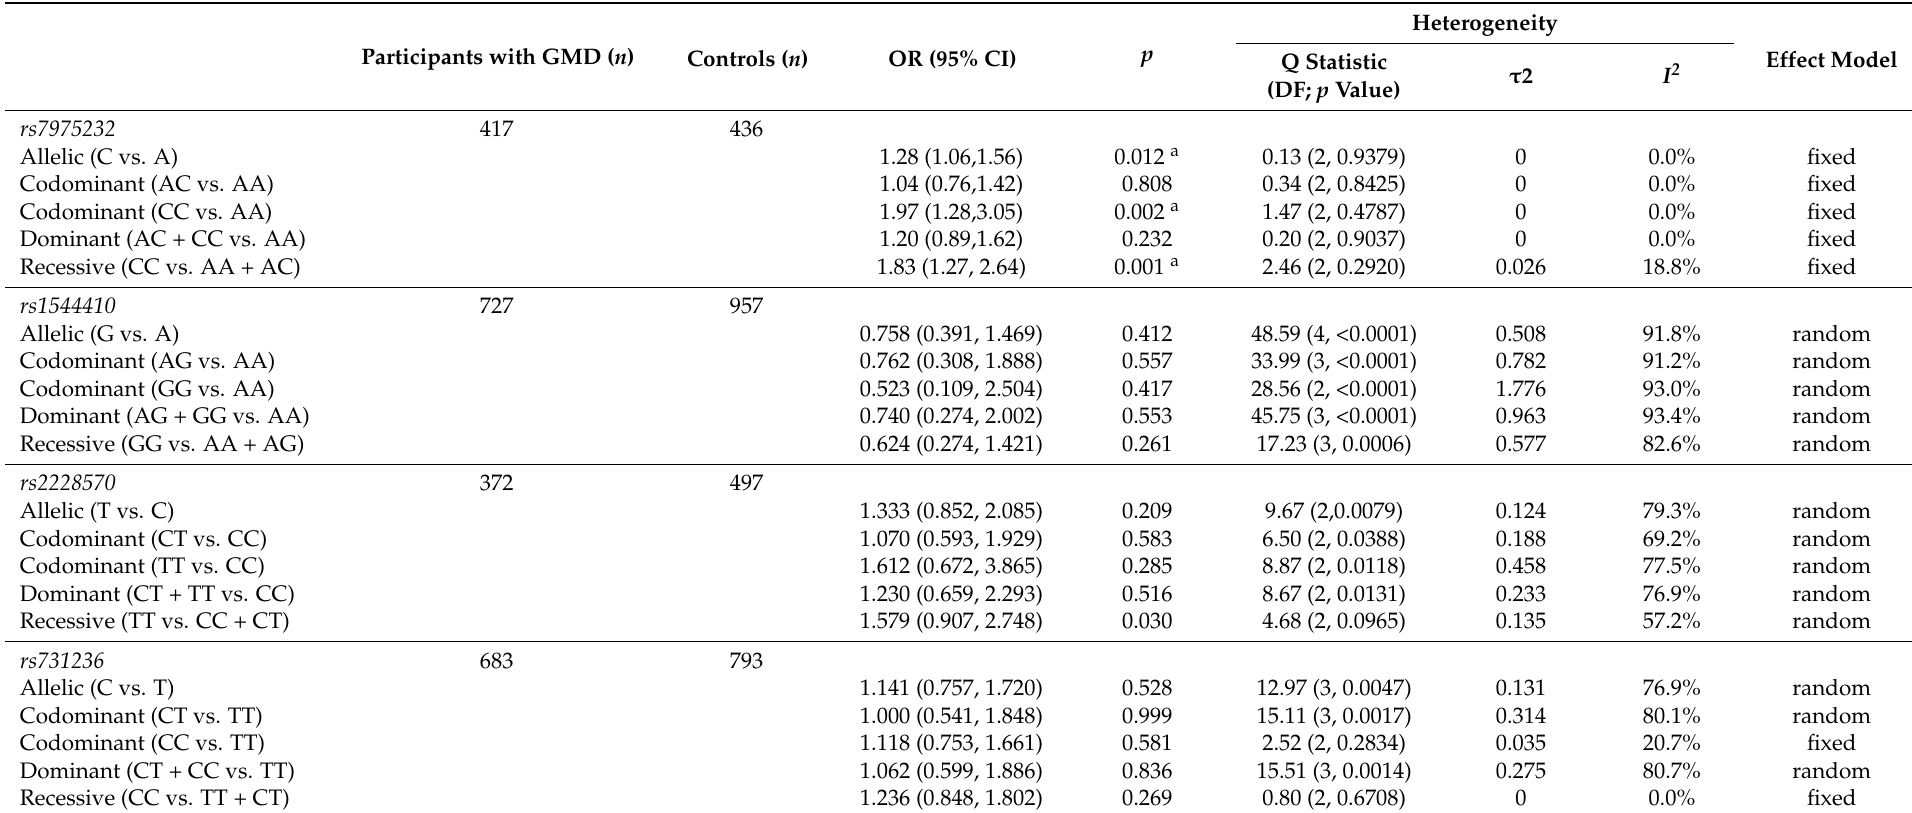
Table 2. Association of vitamin D receptor (VDR) gene polymorphisms and gestational diabetes mellitus (GDM) characteristics as reported in the eligible